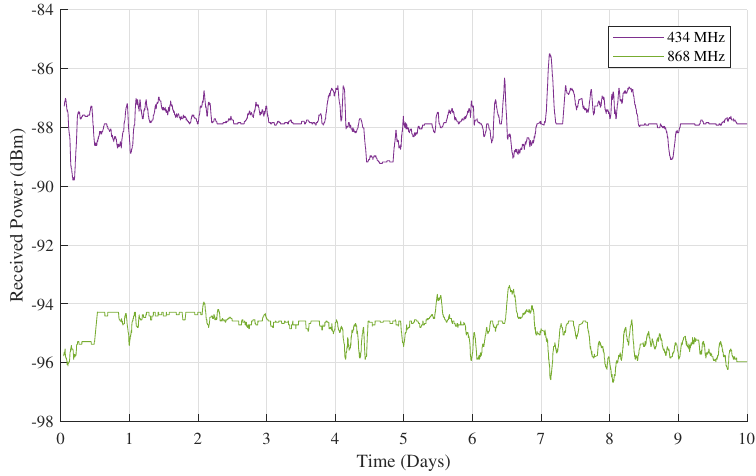
Figure 12. 10 days of outdoor received power measurements gathered at RX2.